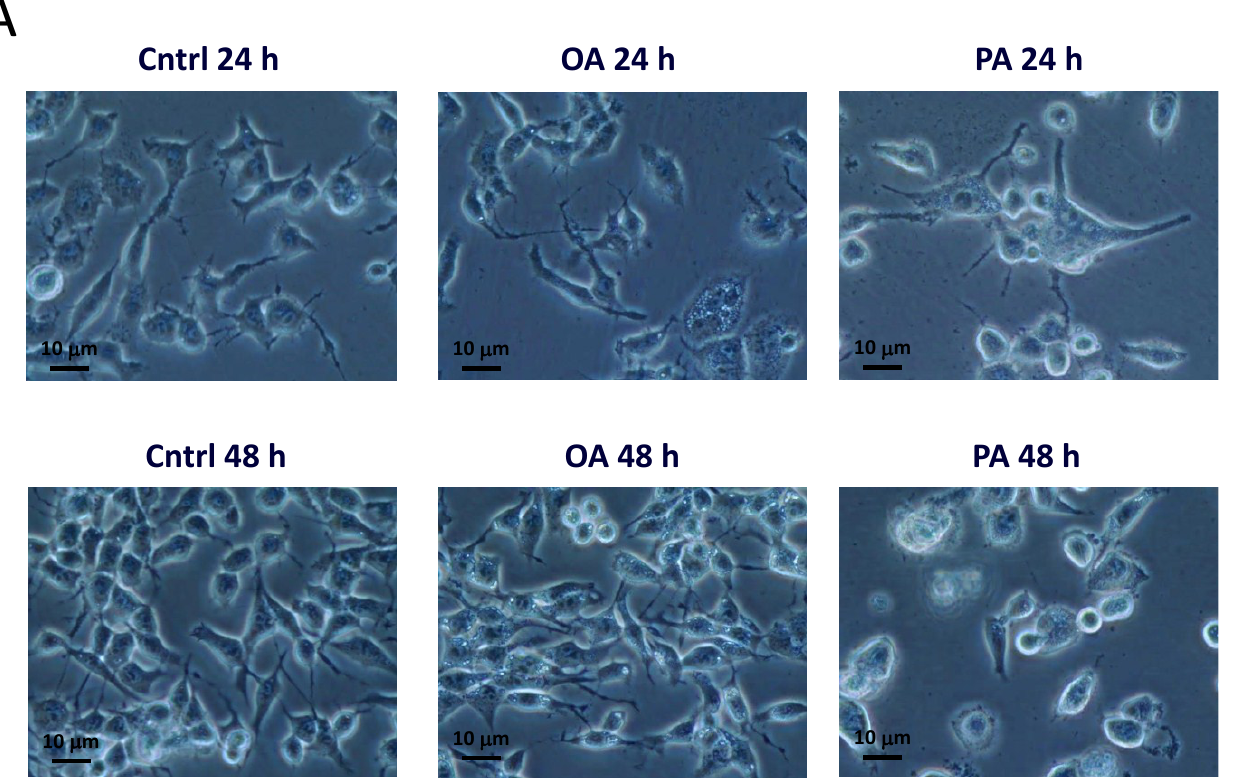
Figure 3. Effects of palmitic acid (PA) and oleic acid (OA) on SH-SY5Y cell morphology. ( A ) Cells were treated with the vehicle control (Cntrl), 0.3 mM OA or 0.3 mM PA for 24 ( top ) and 48 h ( bottom ) and then imaged with a microscope; ( B ) effects of PA and OA on the SH-SY5Y cell size. Cells were treated with the vehicle (Cntrl), 0.3 mM OA or 0.3 mM PA for 24 ( top ) and 48 h ( bottom ), then measured with flow cytometry; ( C ) Effects of PA and OA on the SH-SY5Y cell volume. Cells were treated with PA or OA for 24 and 48 h, and then, the cell volume was quantified by flow cytometry. Data were analyzed by a one-way ANOVA, followed by the LSD test, and are presented as the mean ± SD. * p < 0.05 vs. the Cntrl ( n =